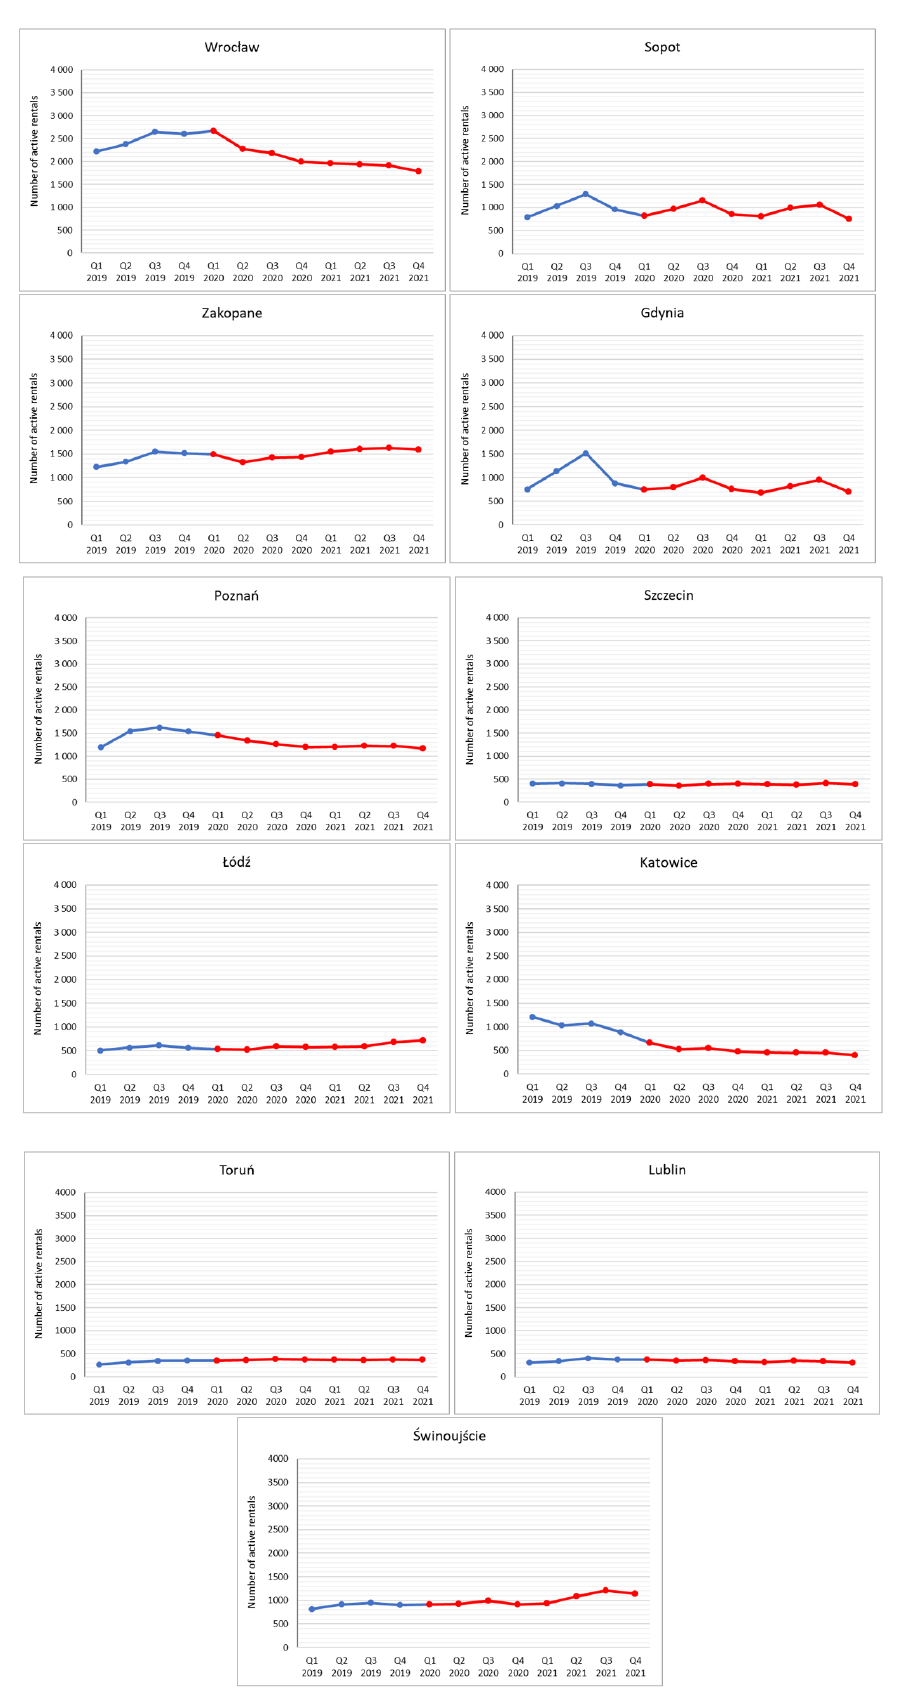
Figure 3. Number of active rentals by quarter (Q) (in cities with the number of rentals below 3000). The situation was different in smaller cities in areas of natural beauty (mountainous Zakopane and seaside Ś winouj ś cie), with a constant increase in active rentals throughout the analysed period, regardless of the pandemic. This increase was probably also caused by pandemic restrictions that limited Poles’ capacity to travel abroad and the aforementioned restriction on city breaks that turned their attention to smaller cities and places in areas of natural beauty, and in this case even to health resort areas. This may